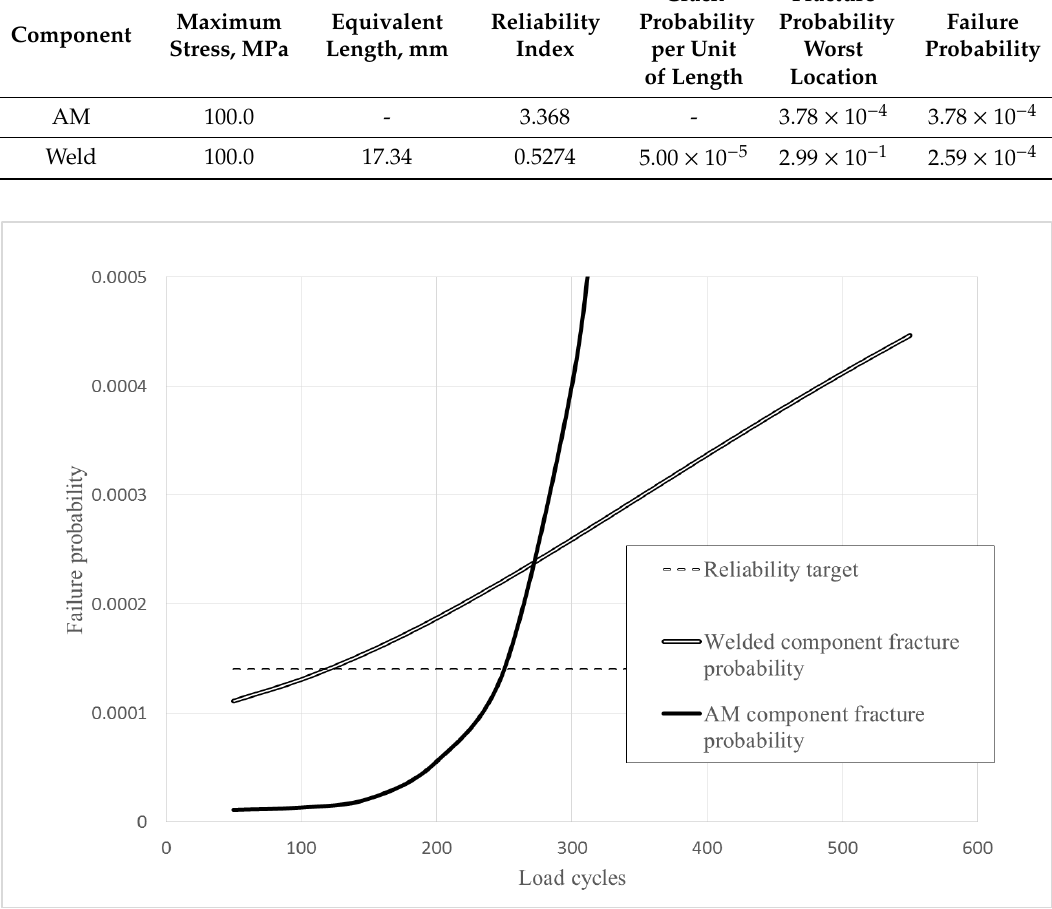
Table 4. AM-case PDF parameters reliability-index sensitivity.